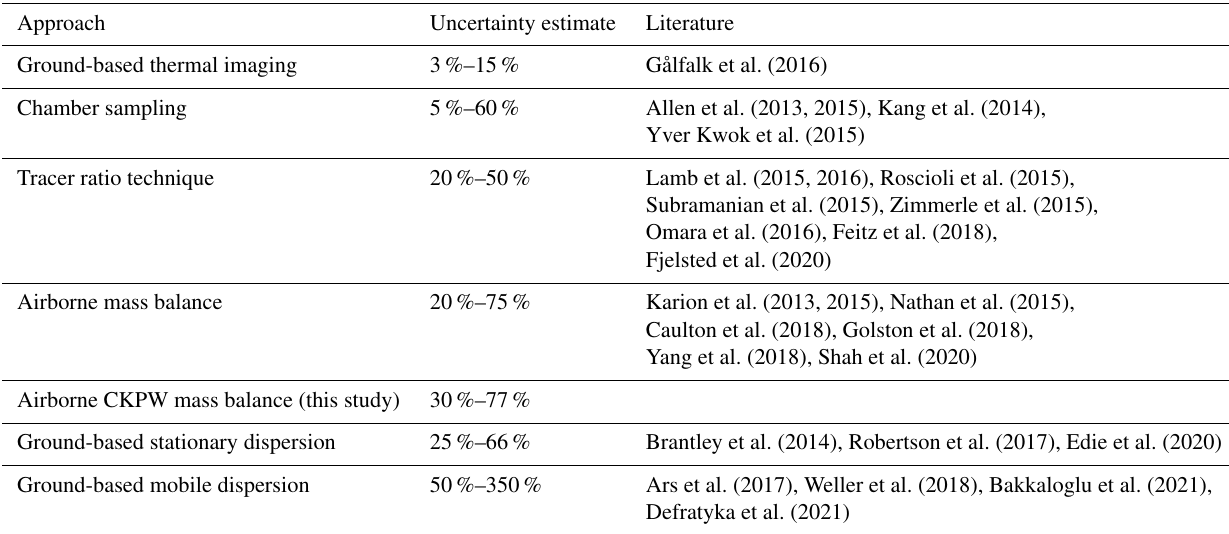
Table 5. Uncertainty of different CH 4 emission quantification